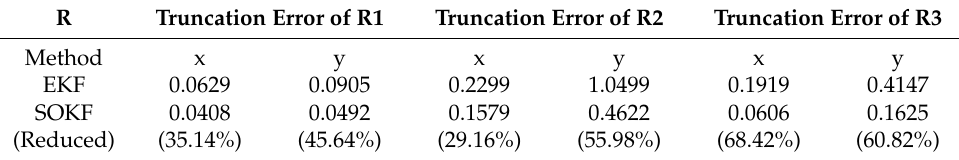
Table 5. Truncation error of trajectory estimation in random topology formation.